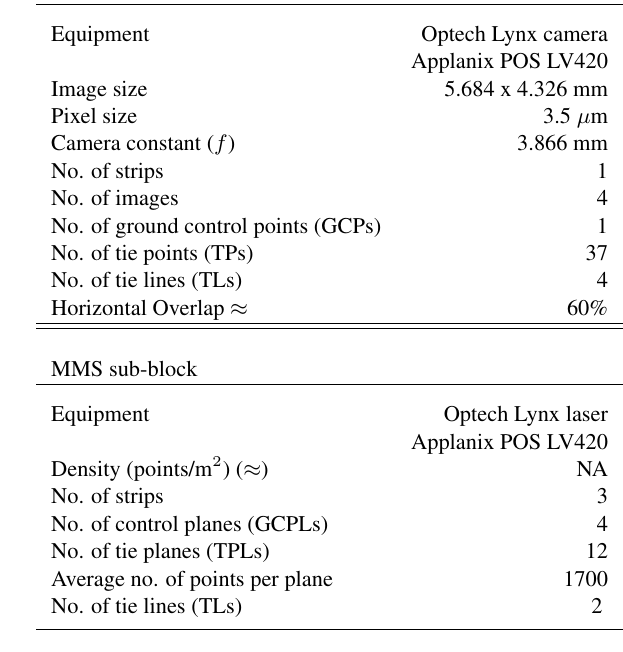
Table 3: Dortmund block geometric configuration.